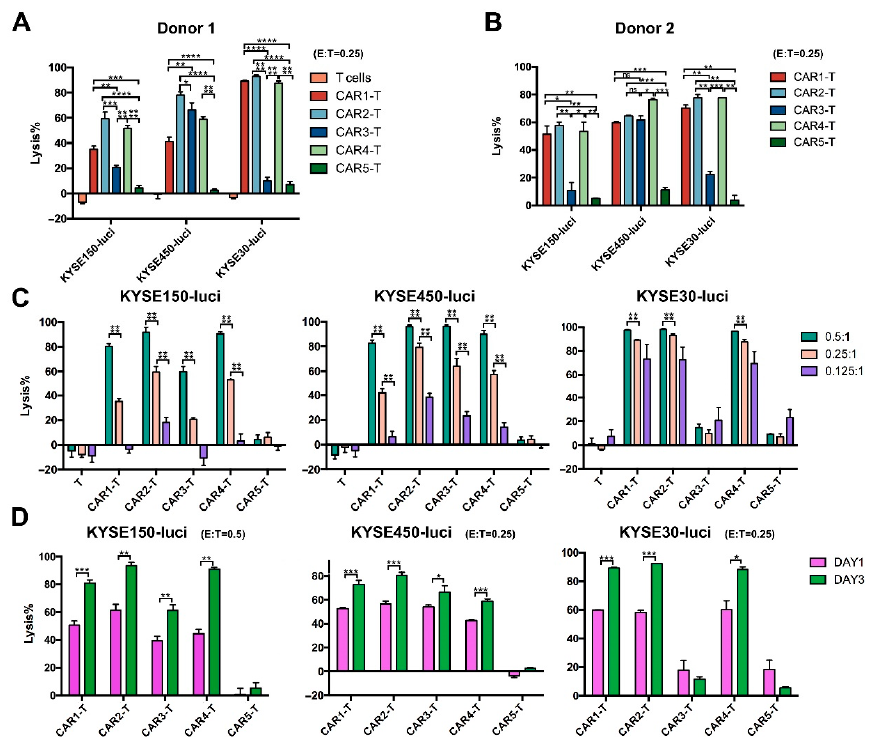
Figure 4. Antitumor effects of five anti-EGFR CAR-T cell lines in vitro. Anti-EGFR CAR-T cells obtained through lentiviral vector transfection were incubated with ESCC cell lines (KYSE150, KYSE450, or KYSE30) at different effector to target (E/T) ratios for different times and were analyzed for cytotoxicity using a luciferase-based cytolysis assay. ( A , B ) Incubation at the E/T ratio of 0.25:1 for 3 days; ( C ) incubation at the E/T ratios of 0.5:1, 0.25:1, and 0.125:1 for 3 days; ( D ) incubation at the E/T ratio of 0.5:1 or 0.25:1 for 1 or 3 days. Unpaired multiple two-tailed t -test. * p < 0.05, ** p < 0.01, *** p < 0.001, and **** p <